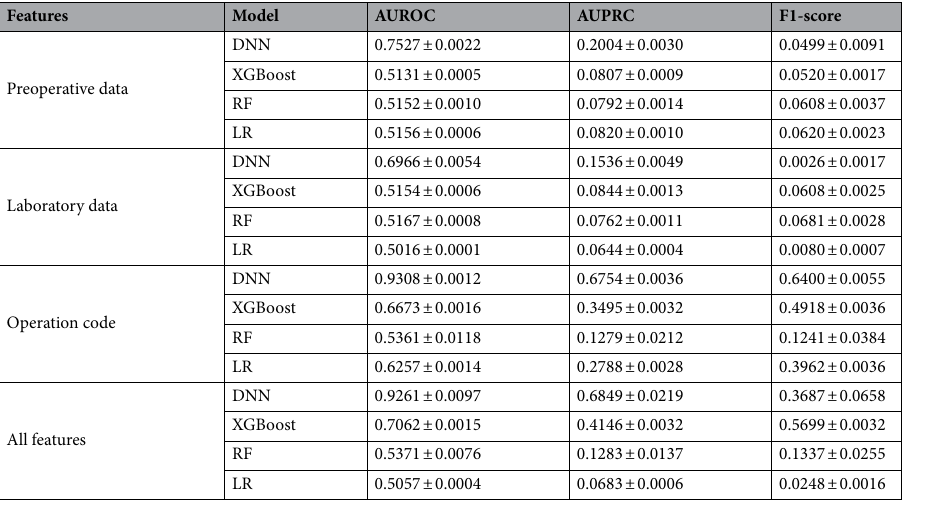
Table 3. Predictive performance of central venous catheterization according to each modeling method using deep learning or machine learning technique for the combination of various features. Data are presented as means (95% confidence intervals). AUROC, area under receiver operating characteristic; AUPRC, area under precision-recall curve; DNN, deep neural network; XGBoost, extreme gradient boosting; DT, decision tree; RF, random forest; LR, logistic regression; ASA-PS, American Society of Anesthesiologists physical